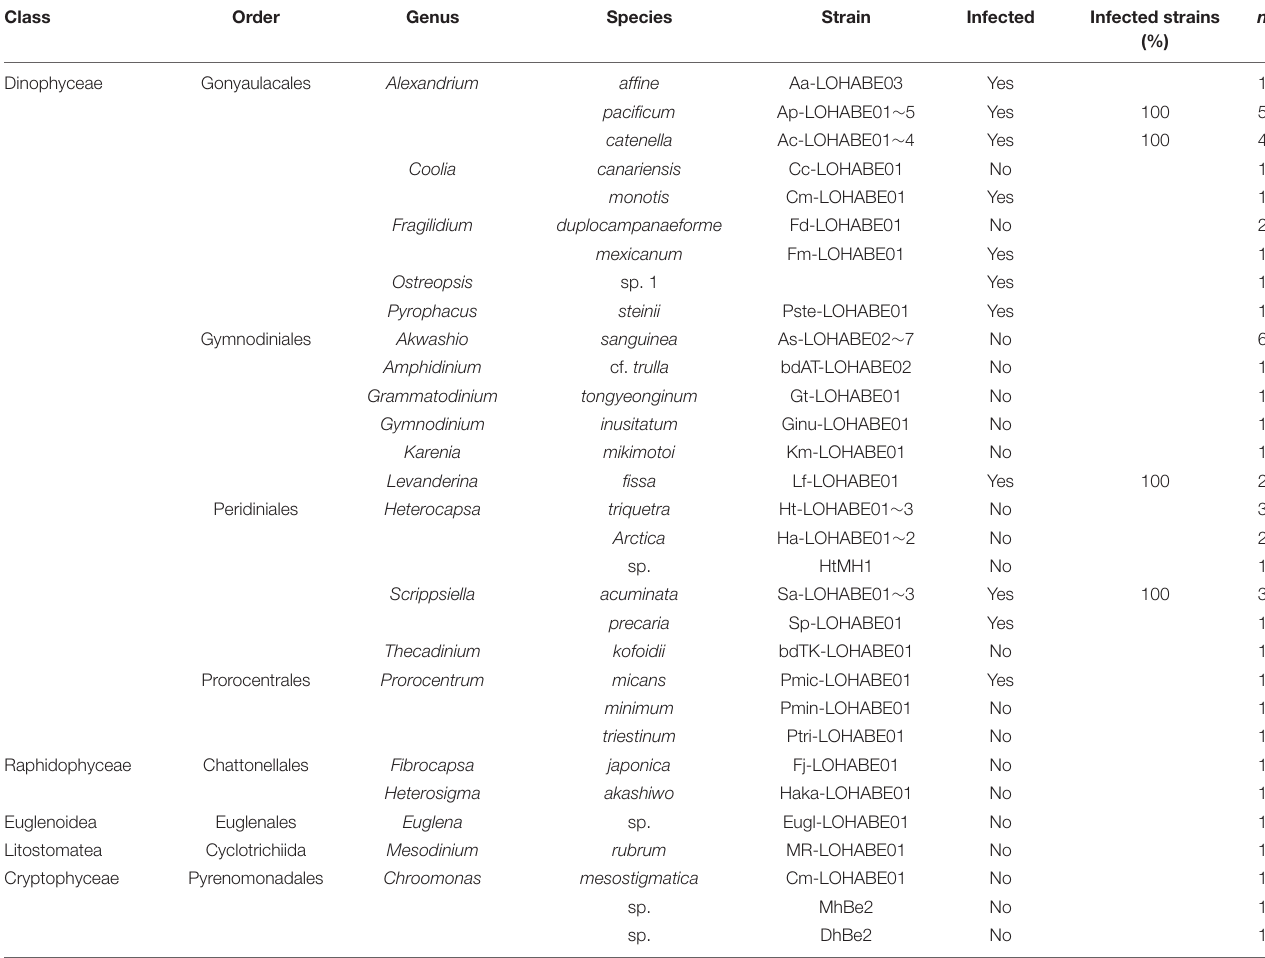
TABLE 1 | Strains of dinoflagellates and other microorganisms infected with Pararosarium dinoexitiosum .